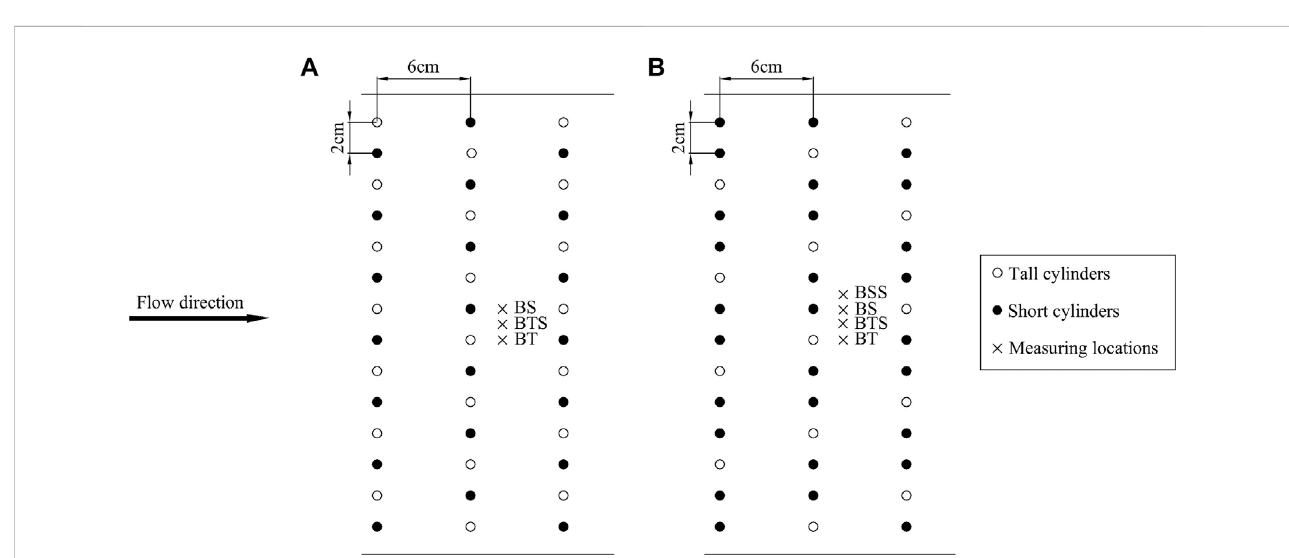
FIGURE 3 The arrangement of vegetation and measuring locations of (A) runs X and (B) runs Y. Black and white circles representing short and tall cylinders respectively, and the crosses represent measurement